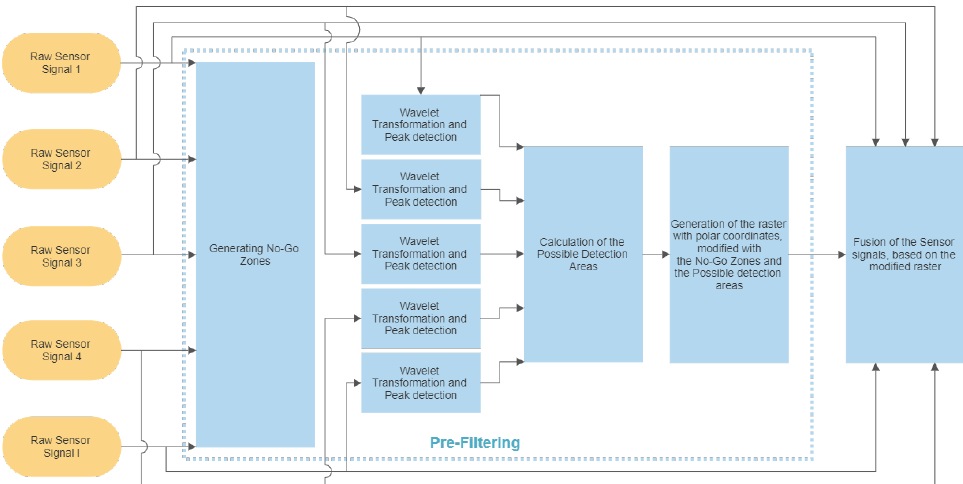
Figure 15. Redefinition of the raster by wavelet-based local refinement steps. The first row shows the low resolution result with the peak points indicated with red, the second row gives the refinement points, and the last row sums up the two previous